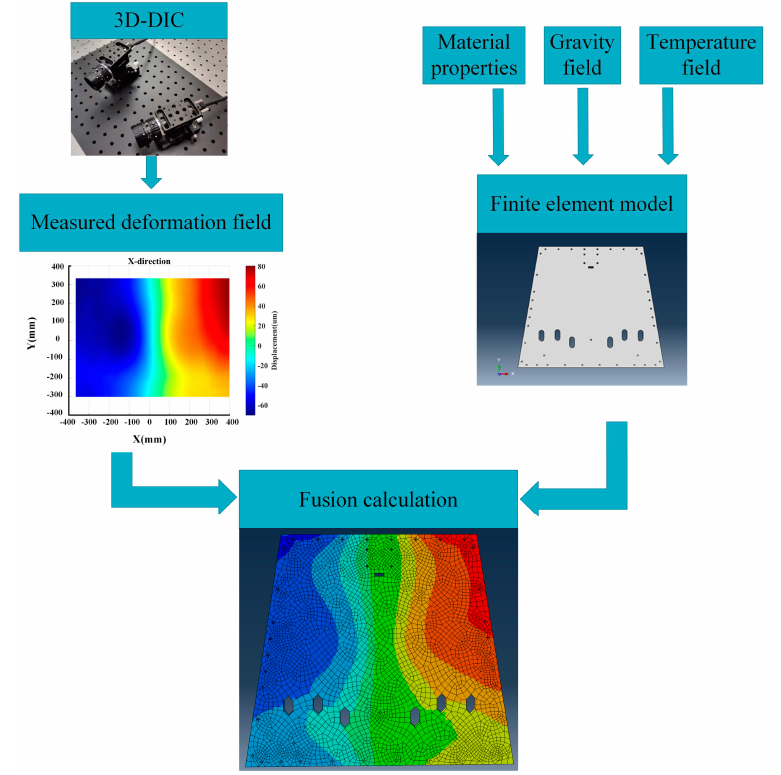
Figure 1. Flow chart of finite element model correction method.